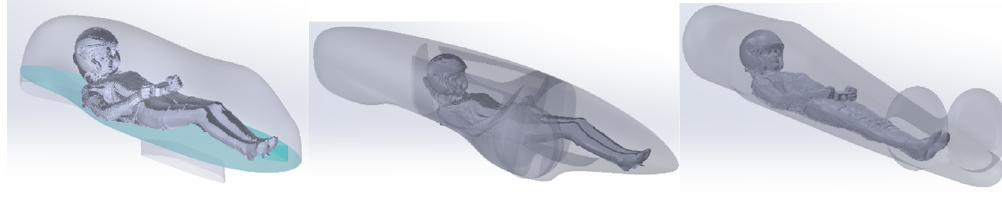
Figure 5. Scanned positions of the woman pilot embedded in the body models.